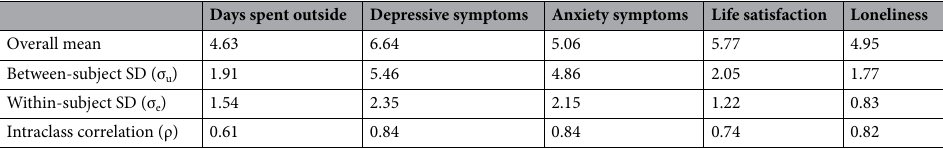
Table 1. Descriptive statistics of days spent outside and mental health and mental wellbeing (N = 35,301; n = 155,366).